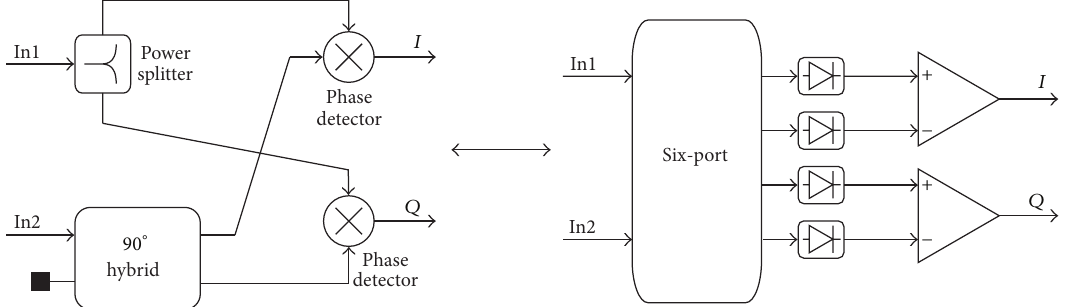
Figure 3: Equivalence between [11] mixer architecture and classical six-port.